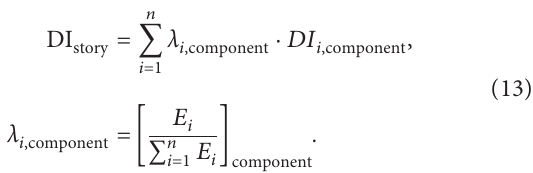
( 0 . 75 T − 3 . 5 T ) for the asymmetric model with β �− 1.0 with respect to (a) magnitude ( M ) and (b) distance ( R A 1 1